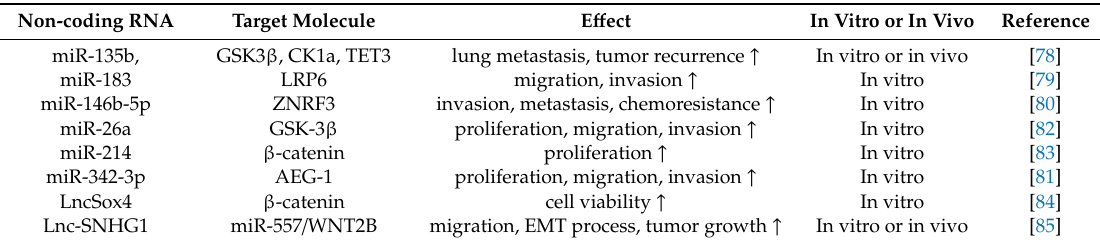
Table 3. Non-coding RNAs related with Wnt / β -catenin pathway promote the OS metastasis and invasion ( ↑ :